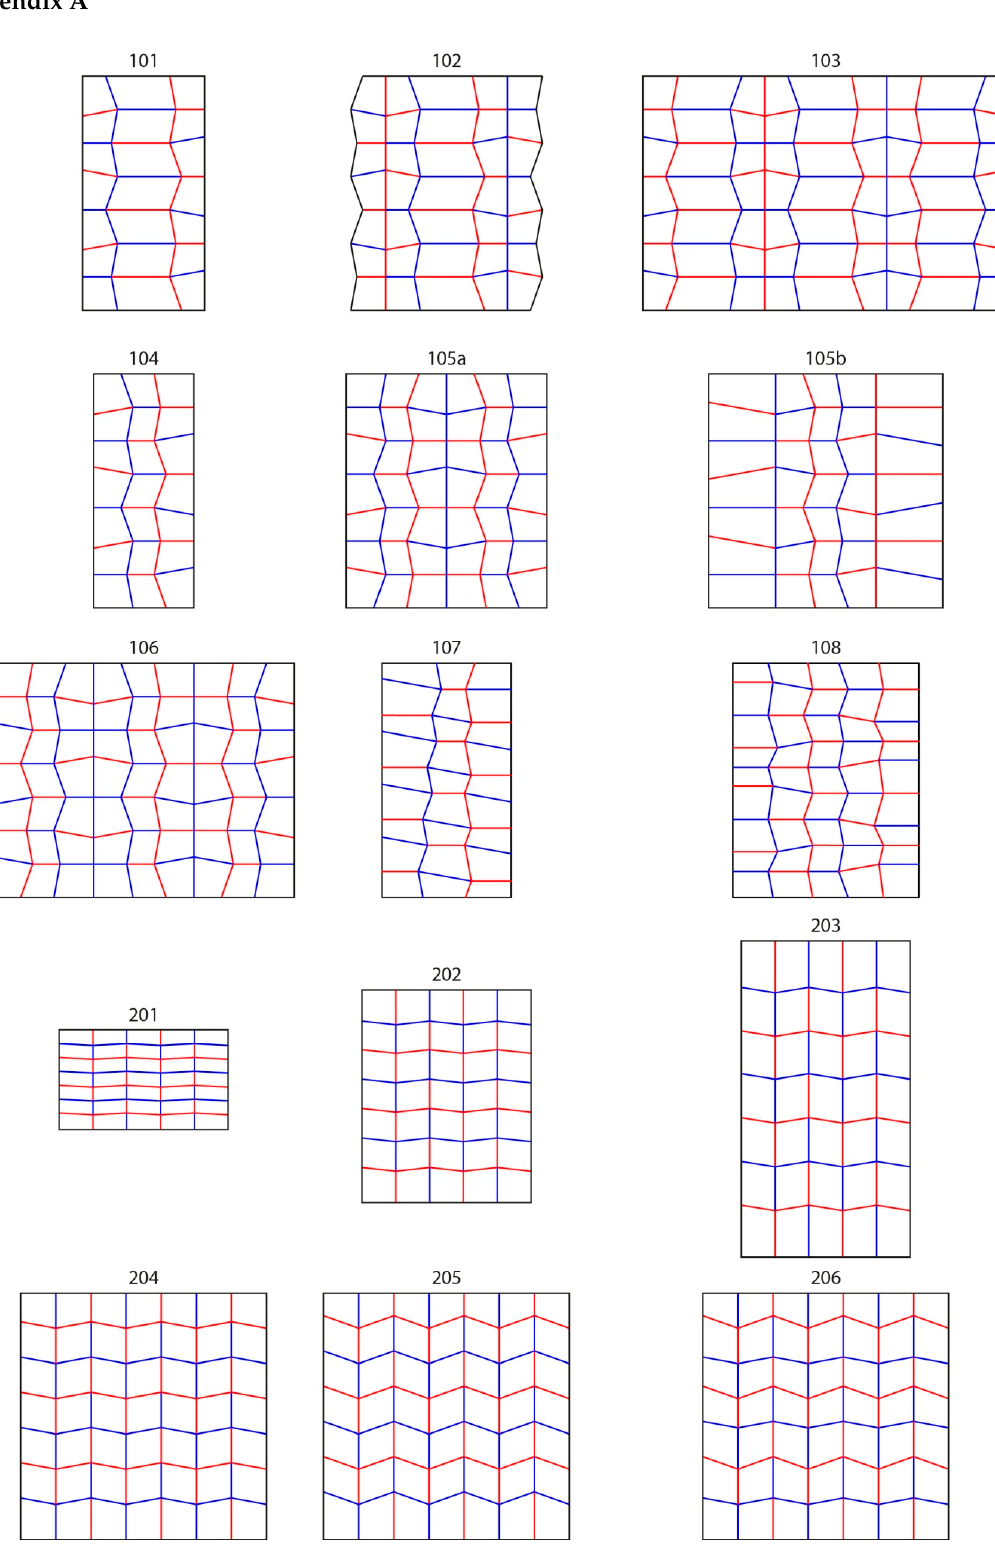
Figure A1. This figure shows the different patterns studied during this research. The numbers starting with a 1 are adapted from the insect wings inspired pattern. The ones starting with a 2 are variations of the Miura-ori pattern.